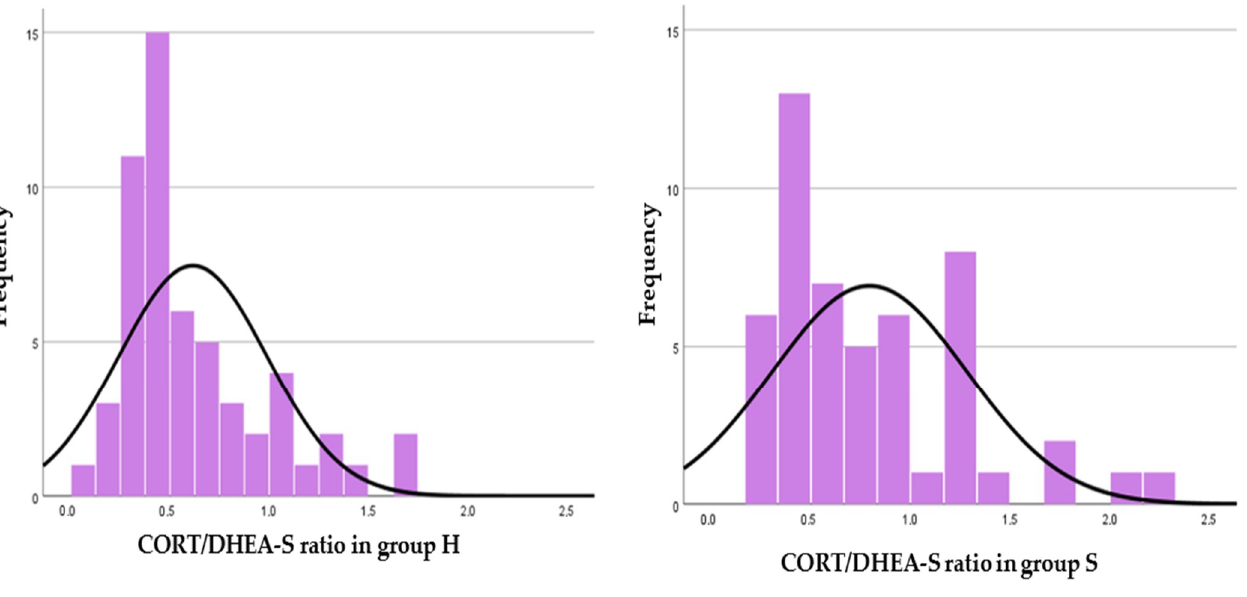
Figure 3. Frequency distribution graphs representing the ratio between foal CORT/DHEA-S ratio and mare CORT/DHEA-S ratio of the two groups (healthy foals—H, left; sick foals—S, right). In study 2, CORT and DHEA-S concentrations in foals and mares and their resulting ratios of HH and HB groups are shown in Table 3; no significant differences were found.